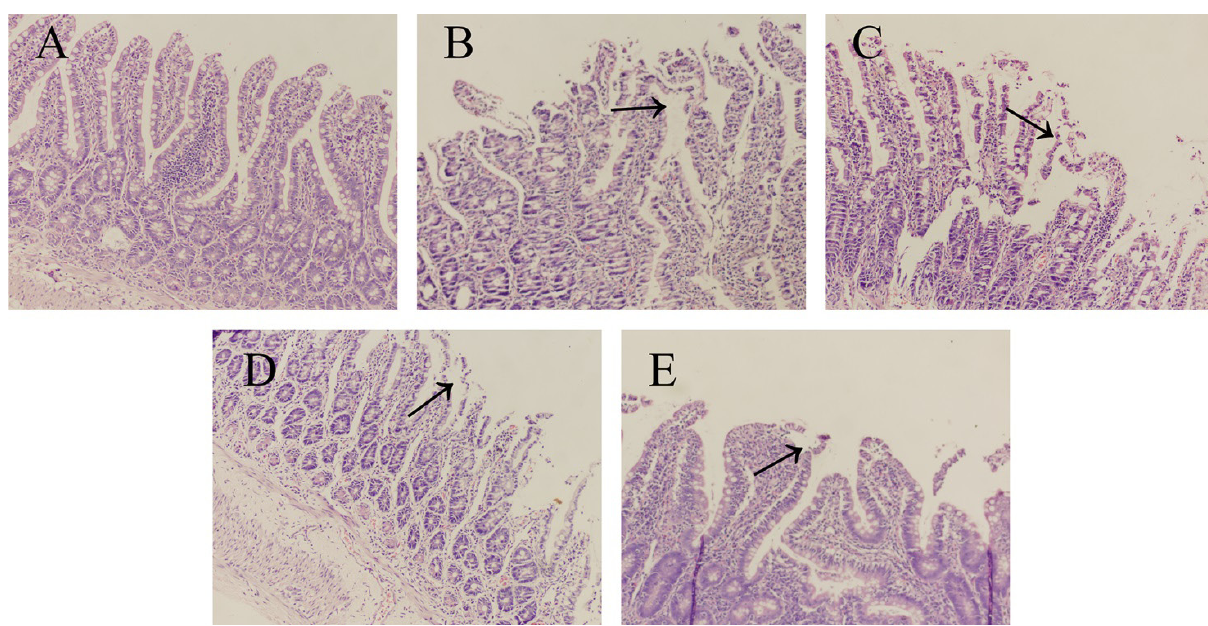
Fig. 3. The pathological sections of intestinal tissue and hematoxylin-eosin staining. The arrows indicate the damage of the cells.